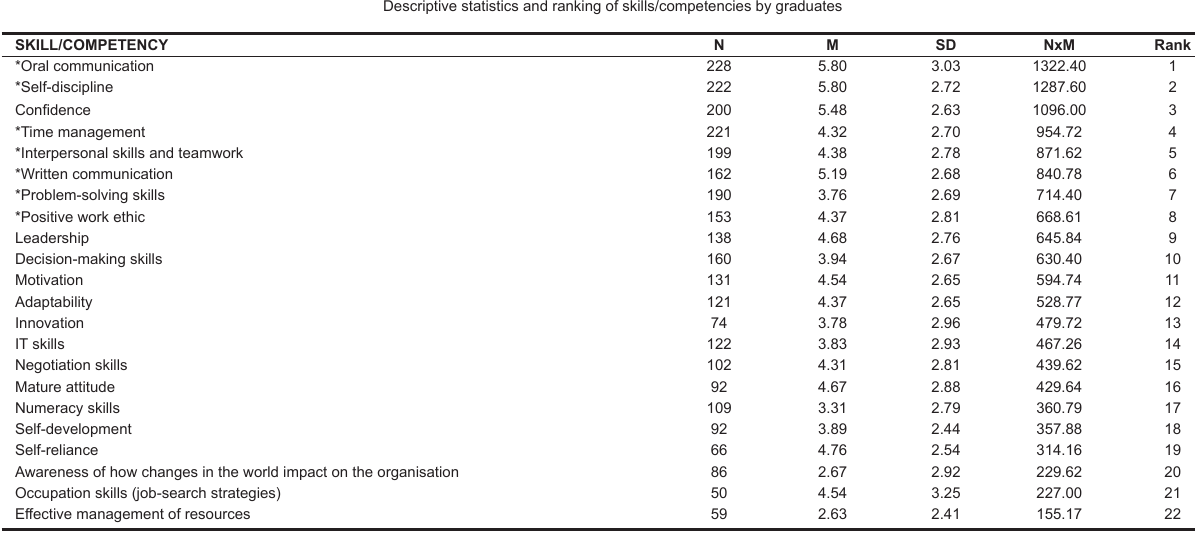
TABLE 5 descriptive statistics and ranking of skills/competencies by graduates